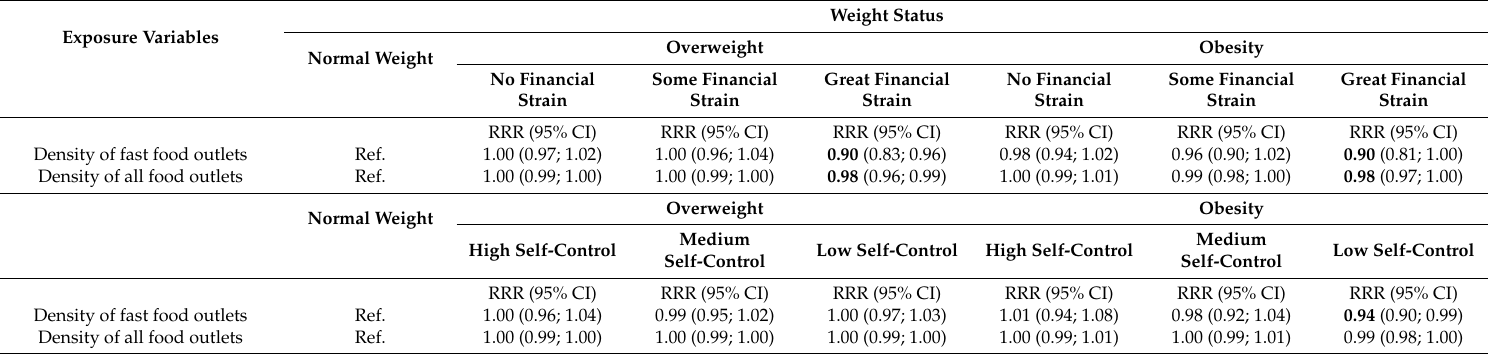
Table 4. Associations between measures of the food environment in a 400 m buffer and weight status stratified by financial strain and